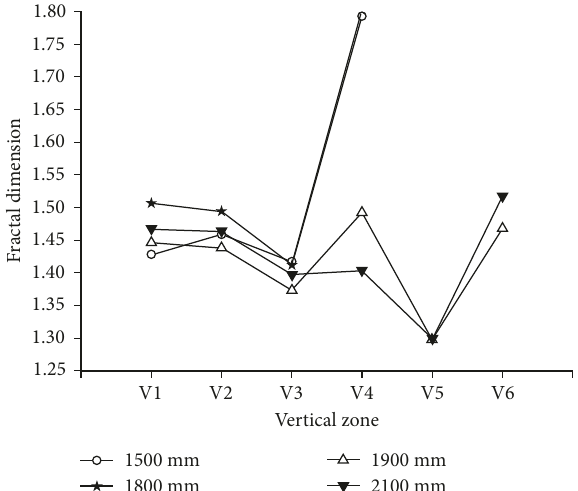
Figure 13: Ratio of the fractal dimension of crack network in different vertical